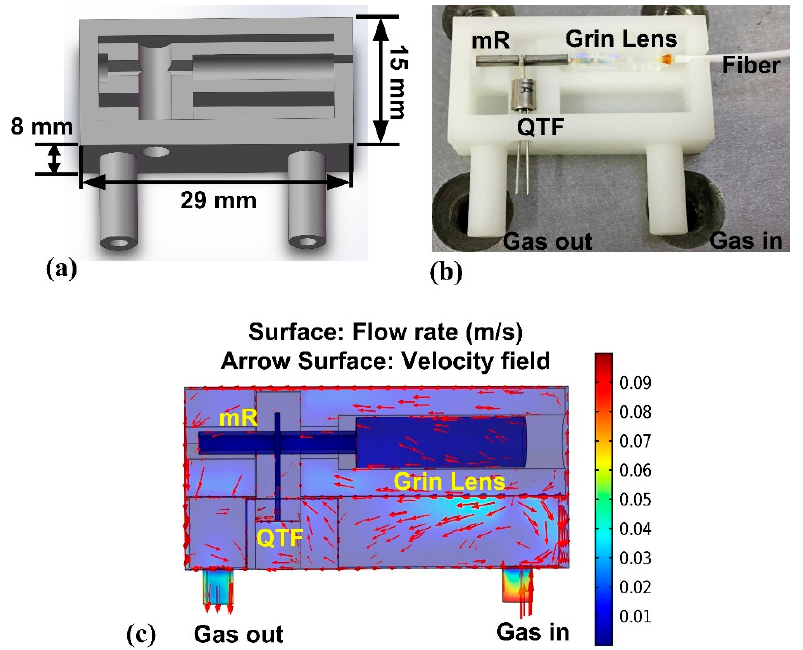
Figure 12. Schematic of the 3D-printed ADM ( a ) Designed 3D model; ( b ) 3D-printed ADM with optical and photoacoustic detection components; ( c ) the flow field within the ADM.